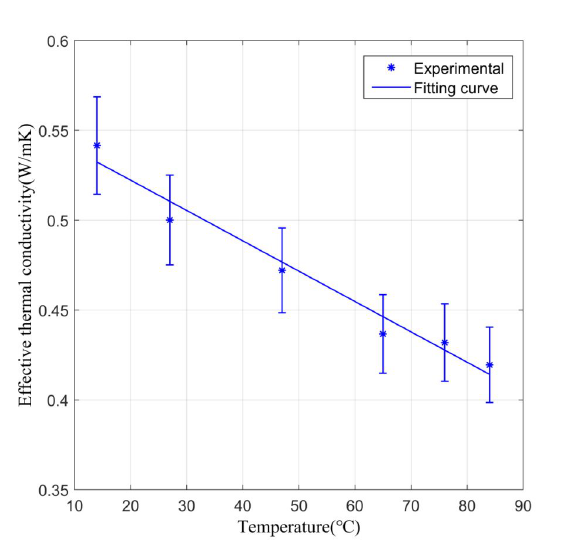
Figure 7: The thermal conductivity of HDPE matrix varies with test